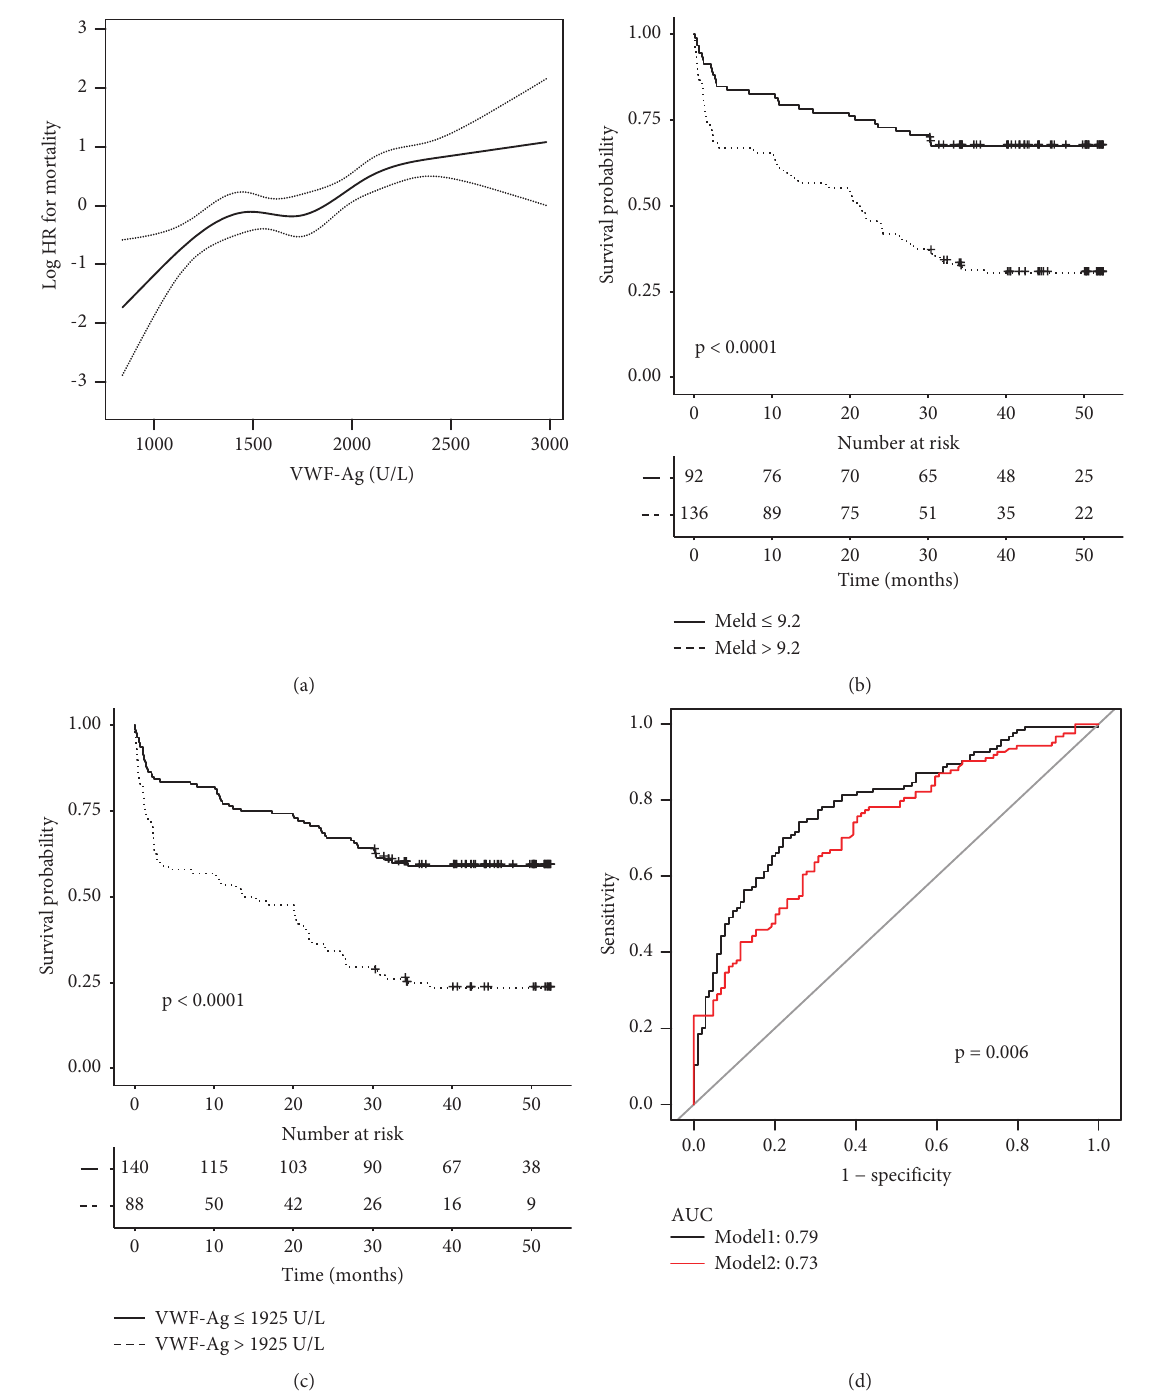
Figure 4: vWF-Ag allowing additional risk stratification on patients with liver cirrhosis during follow-up. (a) Continuous risk for transplant-free mortality (HR) calculated for vWF-Ag. (b) The cumulative probability of transplant-free mortality compared with a vWF-Ag cutoff at 1925 U/L; (c) The cumulative probability of transplant-free mortality compared with a MELD cutoff at 9.2 points; (d) VWF-Ag being able to increase the area under the curve (AUC) of MELD alone for prediction of transplant-free mortality on the patients with liver cirrhosis during